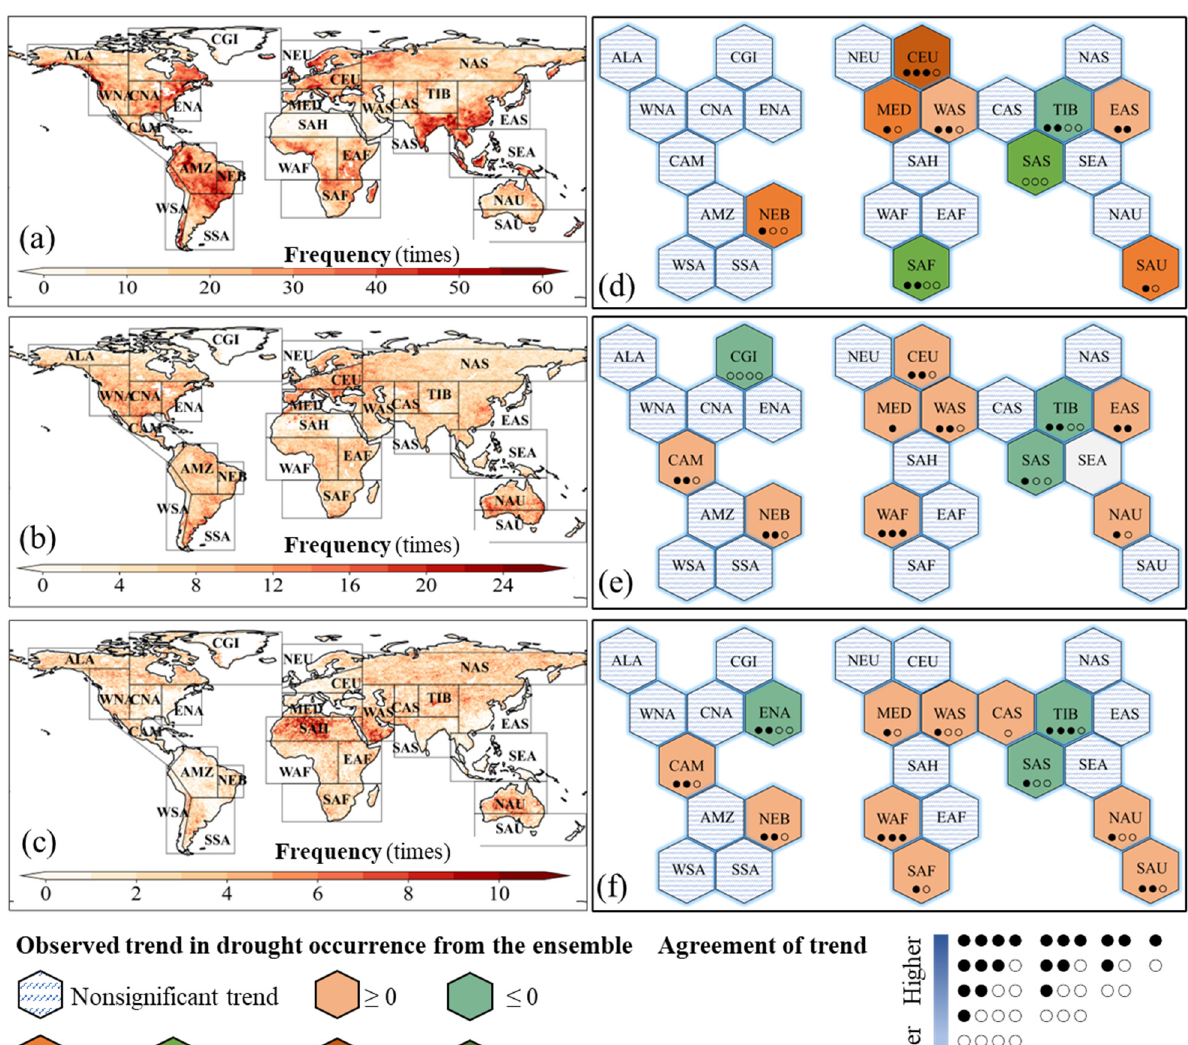
Figure 5. Spatial hotspots ( left , unit: times) and frequency trends across the 26 IPCC-SREX climate divisions ( right , unit: % decade − 1 ) of flash drought ( a , d ), general drought ( b , e ), and creep drought ( c , f ) observed from the ensemble mean during 1980–2019. Only trends that passed the 95% confidence level are shown. The agreement of trend is based on assessing the trend from the individual ensemble members, and it is indicated by a combination of the number of filled or empty dots. One dot means the trend observed from a certain individual member shows a similar direction with the ensemble and filled or empty is determined by the confidence level (filled: greater than 95%).